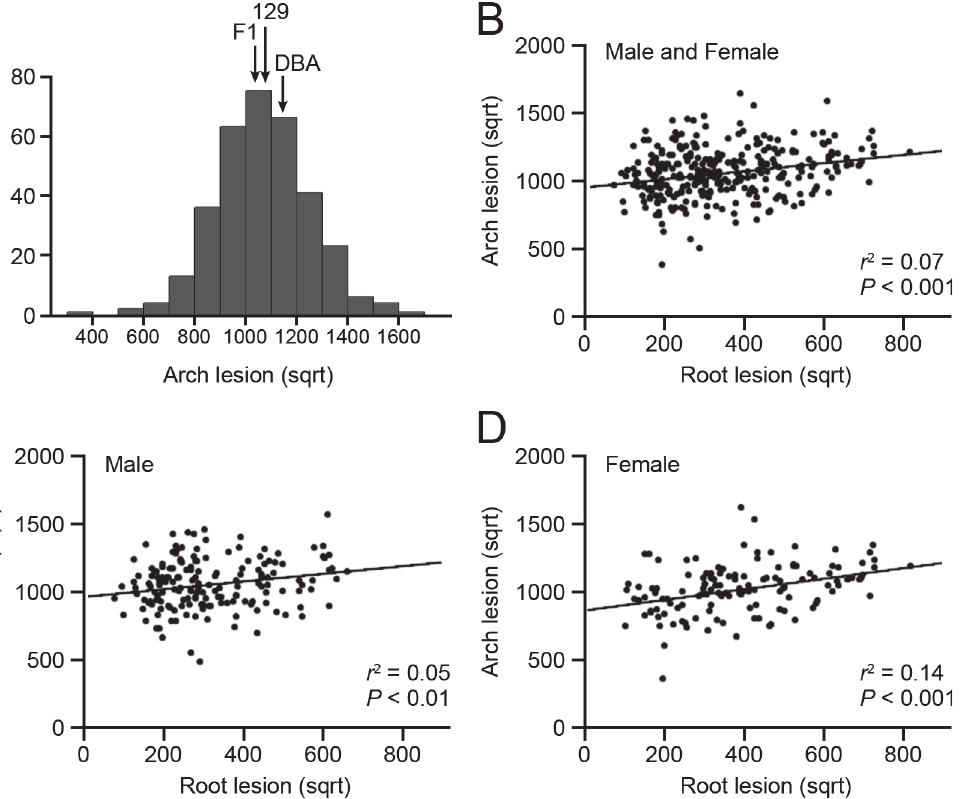
Fig 1. Distributions of the arch plaque size and correlations between the arch and the root plaques. (A) Histograms of square root-transformed atherosclerotic plaque size at the aortic arch in 335 F2 mice derived from 129-apoE and DBA-apoE mice. Arrows represent the positions of average plaque size for parental 129-apoE, DBA-apoE and F1 mice. (B – C) Correlations between arch and root plaque size in males and females (A), males (B), and females